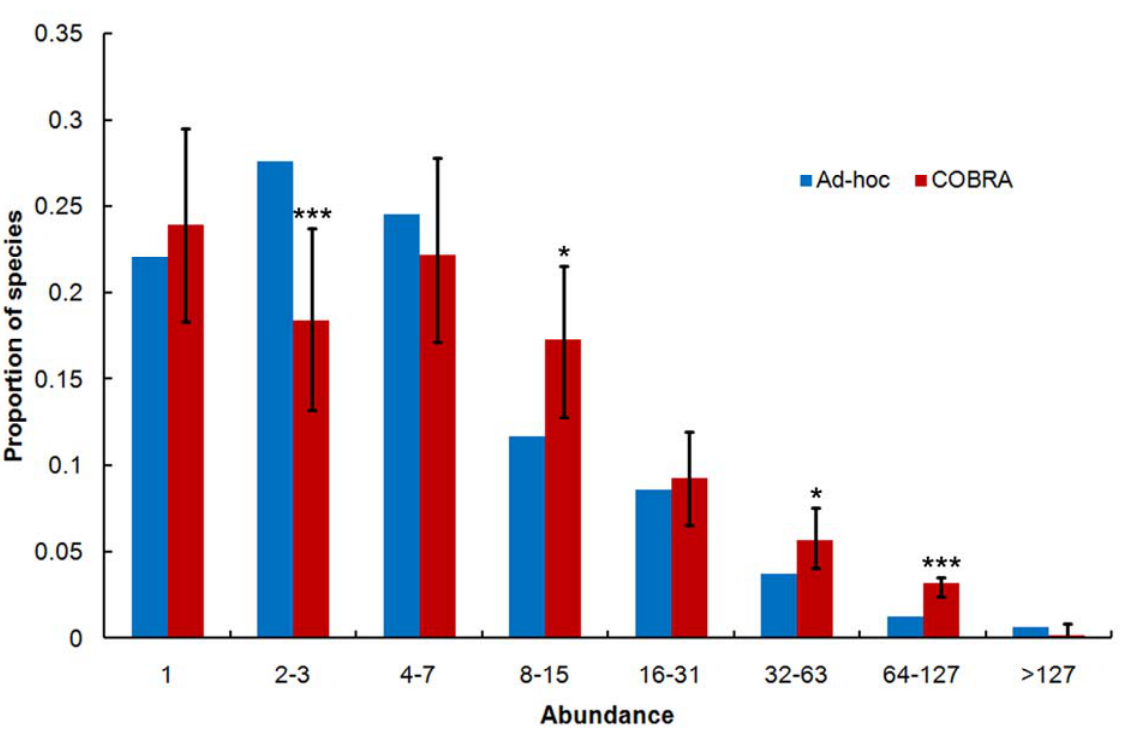
Figure 2. Abundance classes (octaves) for the species communities sampled by the ad-hoc and COBRA approaches. The latter was rarefied to the same number of individuals of the ad-hoc sampling and its 95% confidence limits are indicated, as are the significance levels of comparing the two approaches (* p < 0.05; ** p < 0.01; *** p <